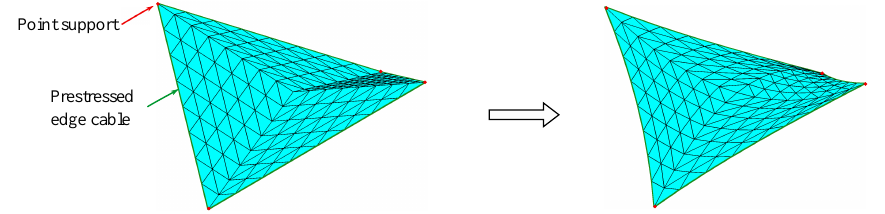
Figure 7. Form-finding analysis of a four-point tent. Left: initial state. Right: equilibrium